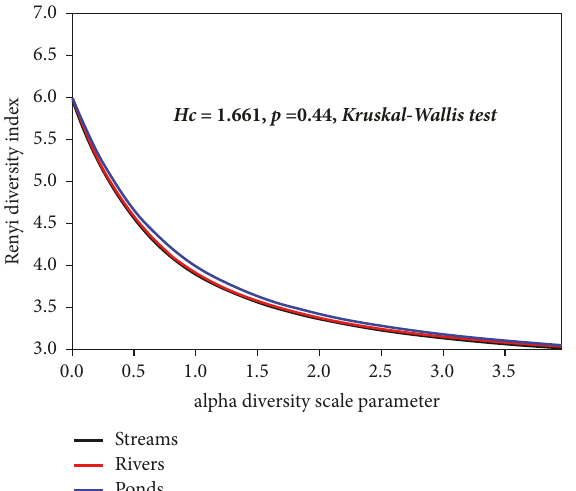
Figure 8: Renyi diversity ordering that compares Odonata evenness and richness of 1403 individuals, across the three water types. Note that the shape of a habitat profile is an indication of its